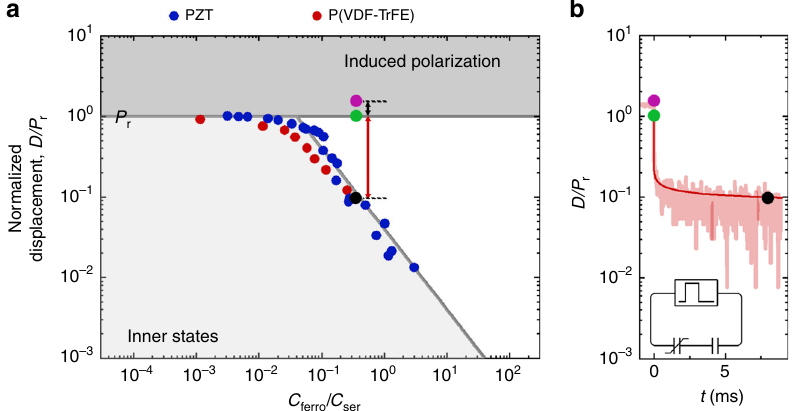
Fig. 5 Depolarization diagram of ferroelectric materials. a The normalized displacement, i.e. the displacement divided by the remanent polarization of the ferroelectric-only capacitor, presented as a function of the ratio of capacitances, C ferro / C ser . The red and blue dots are the retained, normalized polarization of poly(vinylidene fl uoride – tri fl uoroethylene) [P(VDF – TrFE)] and Pb(Zr,Ti)O 3 (PZT), respectively, obtained from the fi nal state of depolarization transients. The values are replotted from Fig. 2. These dots represent the boundary, Eq. (4), between thermodynamically stable and depolarizing initial states. The dark gray area at the top of the diagram represents fully saturated initial states reached at very high applied bias. Upon grounding the electrodes, the induced polarization is discharged. The displacement gets equal to that of the ferroelectric-only capacitor, indicated by the horizontal gray line. At small values of C ferro / C ser the polarization is thermodynamically stable. However, at large values of C ferro / C ser , in the white regions of the diagram, the polarization cannot be maintained, and the state depolarizes. The light gray area in the bottom of the depolarization diagram represents initial polarization states formed by incomplete or partial switching of the polarization. These inner states are thermodynamically stable and for a given displacement the internal fi eld increases with C ferro / C ser and reaches the coercive fi eld at the boundary. b As an illustration we replot a normalized transient for P(VDF – TrFE) from Fig. 3c. The light-colored area corresponds to experimental data, while the solid lines describe the dynamics of depolarization as obtained by numerical calculation (Supplementary Note 4). The purple circle denotes the set initial state and the black arrow indicates the measured discharge of the induced polarization. Subsequently, the discharged state corresponding to the green circle depolarizes, as indicated by the red arrow. The fi nal state is indicated by the black